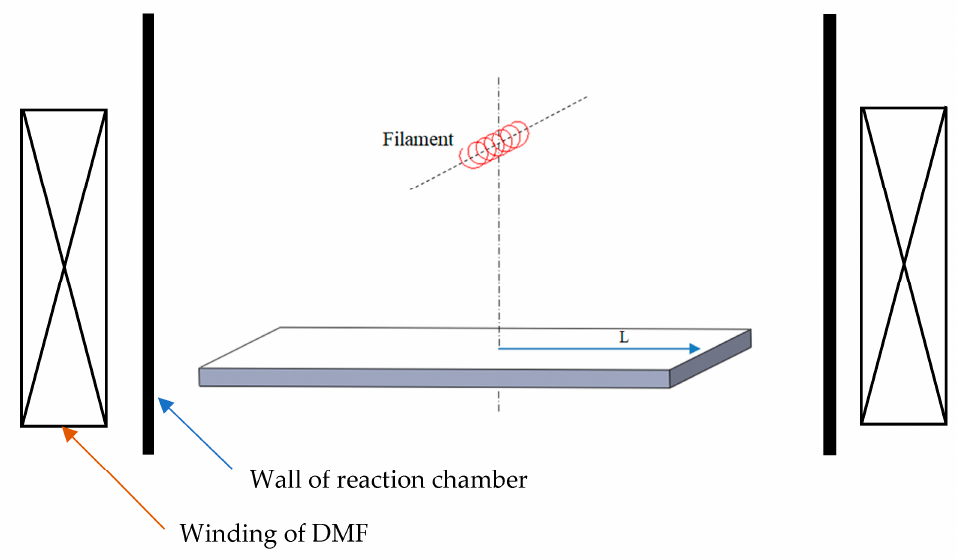
Figure 1. Schematic diagram of experimental apparatus.